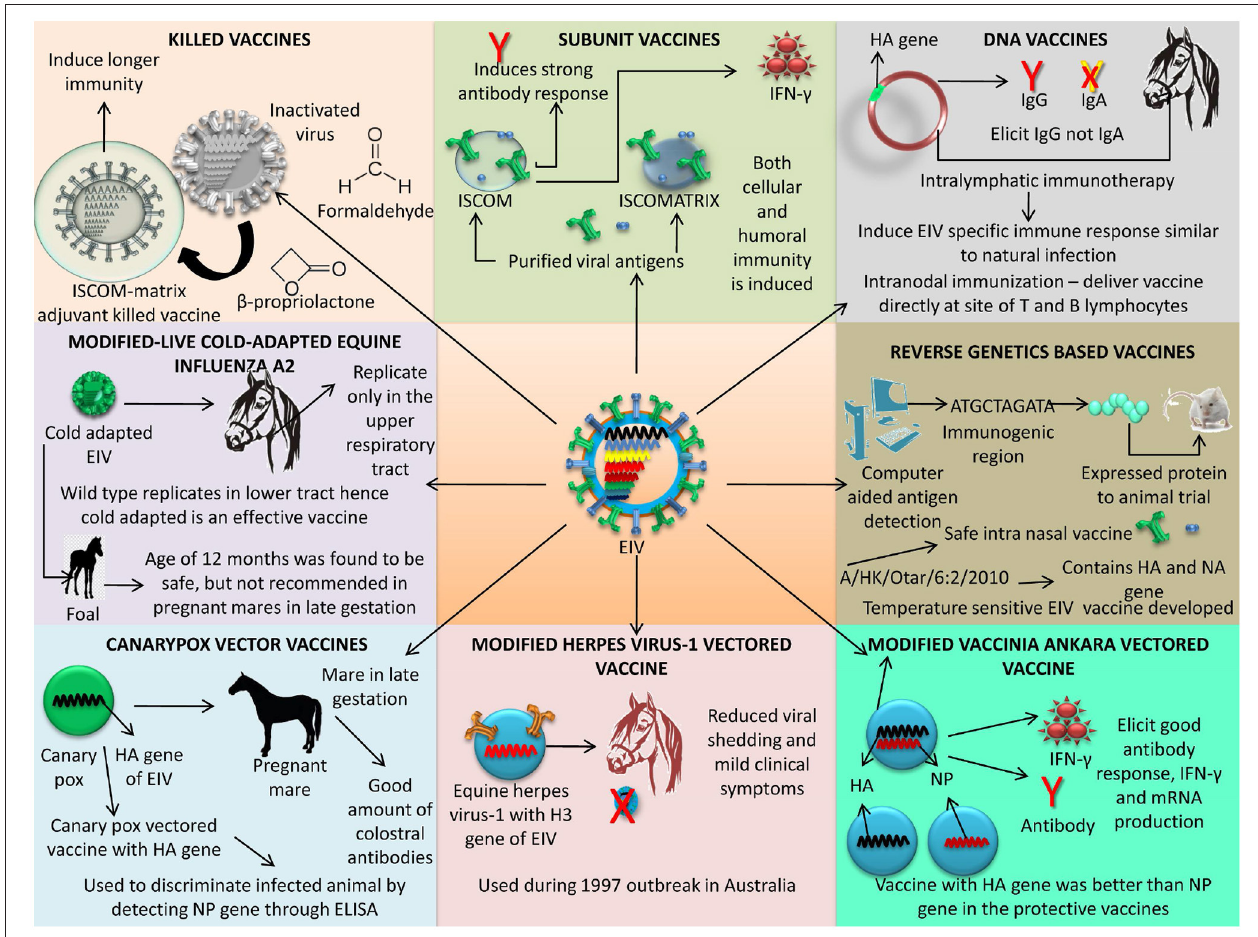
FIGURE 5 | Different vaccine platforms available for EIV. Platforms include killed vaccine, inactivated vaccine, subunit vaccine, DNA vaccine, subunit vaccine, vectored vaccine, reverse genetics-based